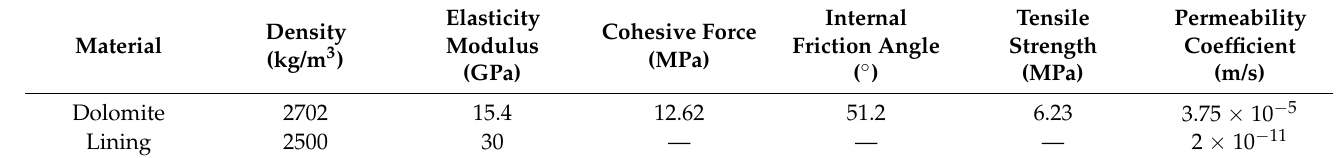
Table 1. Mechanical parameters and permeability